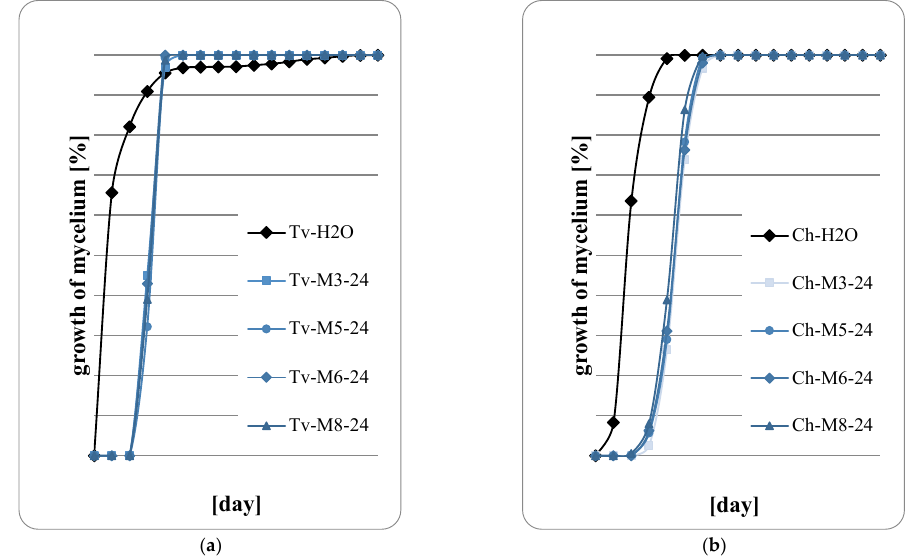
Figure 6. Fungal growth on wood: ( a ) T. viride; ( b ) Ch. globusom (explanation of symbols in the legend: Ch-H20—control, 24—sample code indicating the application of 600 g of extract per m 2 , M3— M.